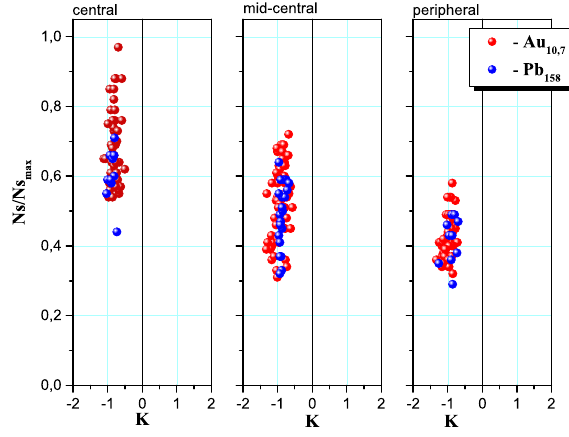
Figure 3. E-by-E Kurtosis (K) analysis for (Au, Pb) + (Ag / Br) interactions